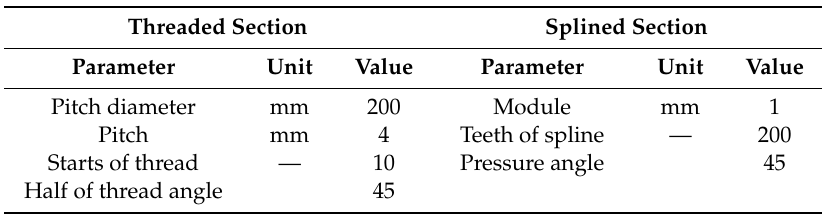
Table 3. Parameters of synchronous rolling die. Threaded